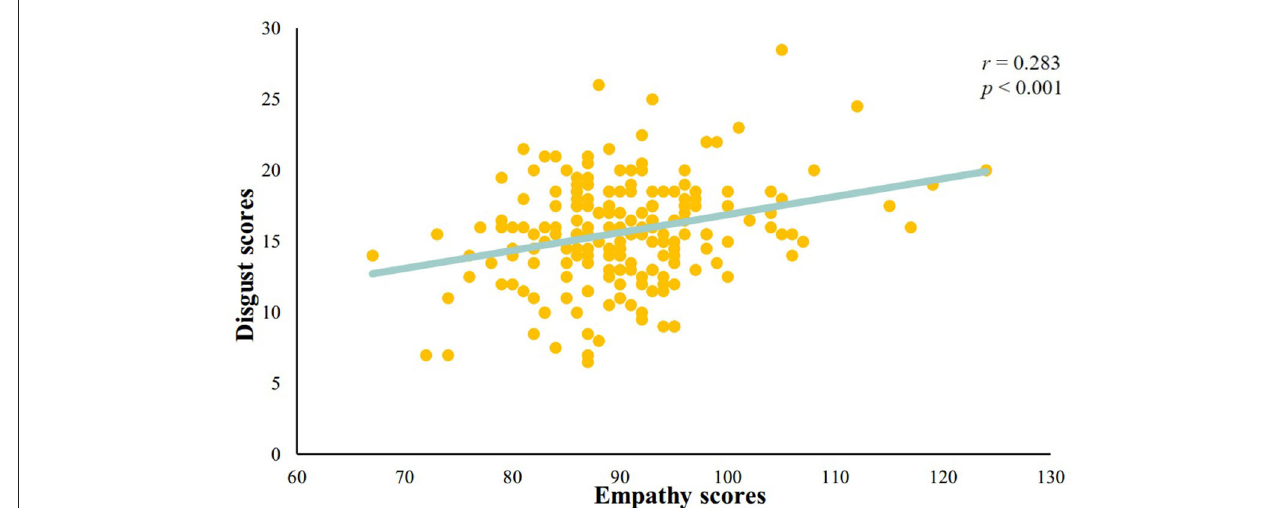
FIGURE 2 | A significant positive correlation between disgust sensitivity score and empathy score.